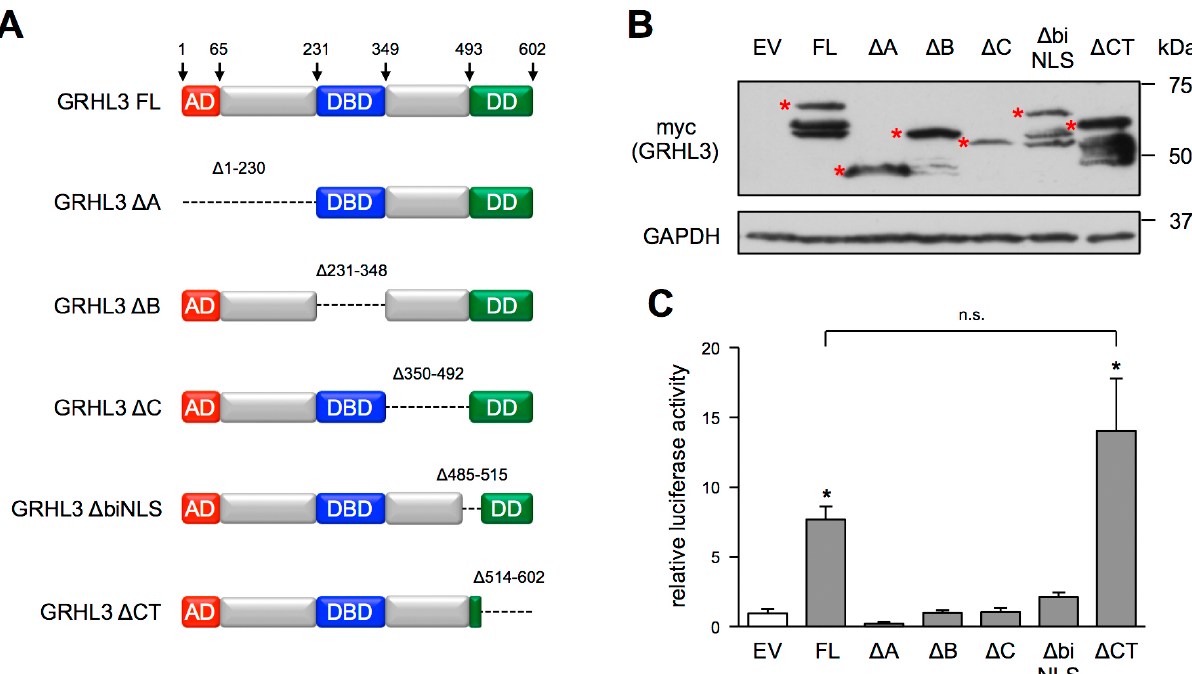
Figure 2. Transcriptional activity of full-length GRHL3 (GRHL3 FL) and of various deletion mutants in HEK293 cells. ( A ) Schematic representation of the GRHL3 variants ∆ denotes the deleted amino acids (AD = predicted activation domain; DBD = predicted DNA-binding domain; DD = predicted dimerization domain). ( B , C ) HEK293 cells were co-transfected with a GRHL3-specific luciferase reporter construct and expression vectors for the GRHL3 variants shown in ( A ). ( B ) Expression of the different GRHL3 variants was verified by immunoblot (upper panel, * marks proteins of the expected sizes), GAPDH served as a loading control (lower panel). ( C ) Luciferase activity was measured in cell lysates and is shown relative to cells co-transfected with an empty vector (EV) instead of GRHL3 variants (data are mean ± SEM, n = 4–10, * p < 0.05 vs. EV).